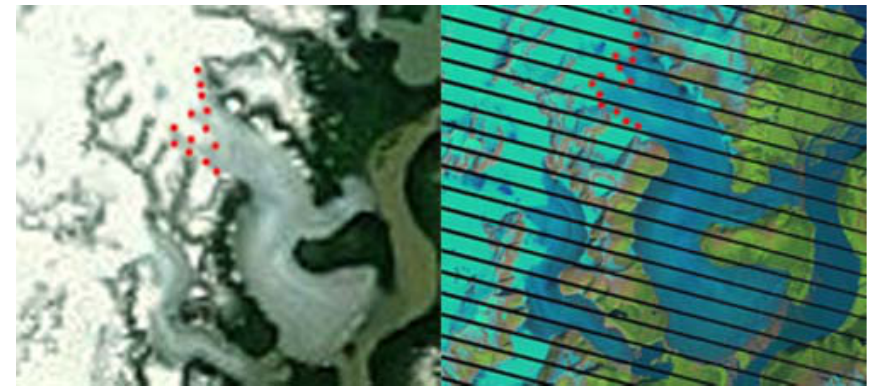
Fig. 2. Side by MODIS and Landsat 7 image from 292009 is provided with the TSL noted with red dots on each image.